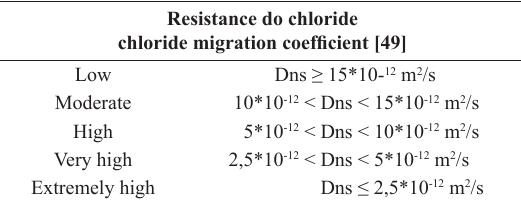
Table 5. Concrete classification according to chloride penetration test